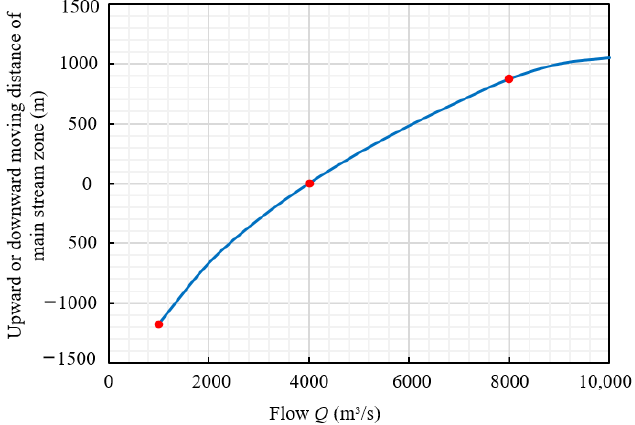
Figure 5. Relationship between the flow and upward or downward moving distance of main stream zone.